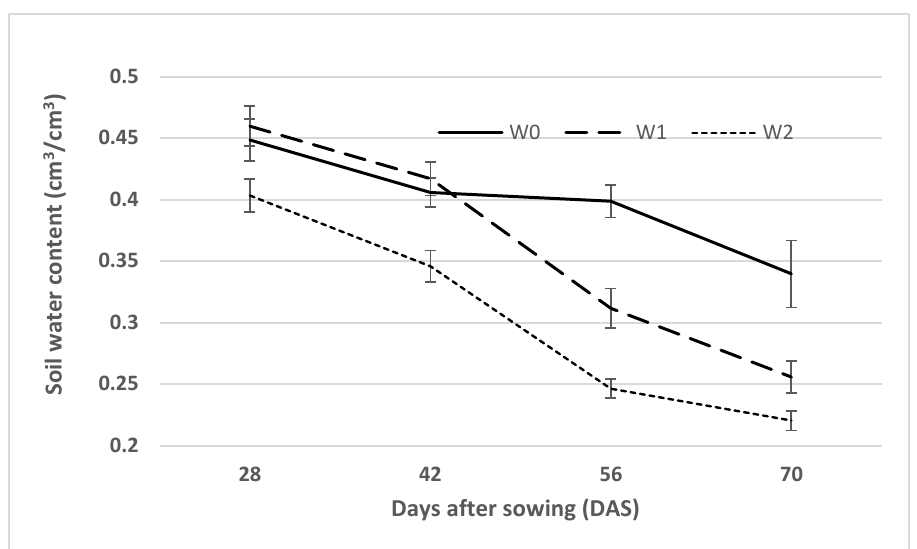
Figure 2. Average volumetric soil water content (cm 3 /cm 3 ) at 28 days after sowing (DAS) ( p = 0.007), 42 DAS ( p = 0.007), 56 DAS ( p < 0.001), and 70 DAS ( p = 0.042) at the Vermase site in 2018. W0, well-watered control; W1, water withheld from flower initiation to maturity; W2, water withheld after seedling establishment to maturity. Bars indicate the standard error of means.